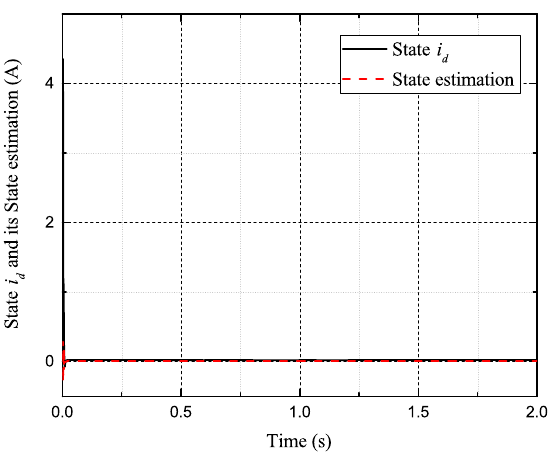
Figure 19. State i d and its estimated value ˆ i d .